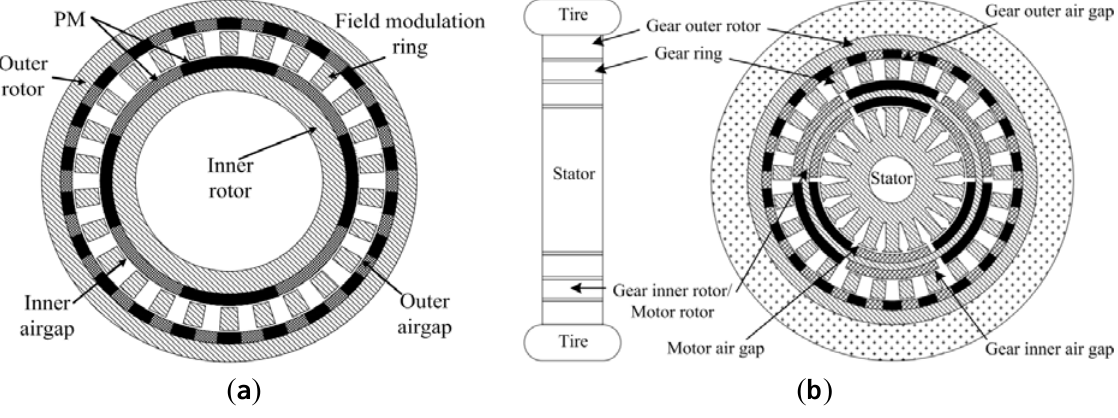
Figure 14. Magnetic gear. ( a ) Coaxial magnetic gear; ( b ) Magnetic-geared in-wheel